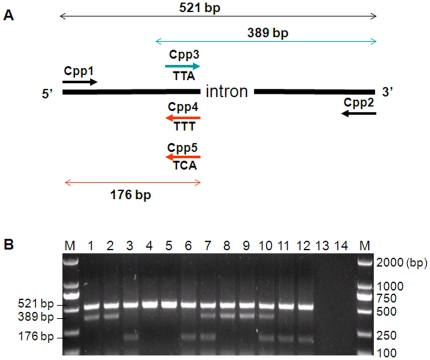
Allele-Specific PCR (AS-PCR) for kdr genotyping.
A: Schematic representation of the primer location and predicted size of PCR products. Cpp1–Cpp5 indicate PCR primers in which sequences are reported in Table 5. Primer pair Cpp2 and Cpp3 amplifies a 389 bp fragment for the wildtype susceptible allele (for codon TTA). Primer pair Cpp1/Cpp4 yields a 176 bp fragment for resistant L1014F allele (codon TTT). Similarly, primer pair Cpp1/Cpp5 leads to amplification of a 176 bp fragment diagnostic to the L1014S resistant allele (for codon TCA). B: An example of AS-PCR gel. Two PCR reactions were run in parallel for each specimen (lanes 1 and 2 for specimen 1; lanes 3 and 4 for specimen 2…). Samples in lanes 1, 3, 5, 7, 9 and 11 were amplified with the primers Cpp1, Cpp2, Cpp3 and Cpp4 to detect wildtype L1014 (TTA) and resistant L1014F (TTT) alleles, whereas samples in lanes 2, 4, 6, 8, 10 and 12 were amplified with primers Cpp1, Cpp2, Cpp3 and Cpp5 to detect wildtype L1014 (TTA) and resistant L1014S (TCA) alleles. Lanes 13 and 14 were negative control. Genotype results: specimen 1: TTA/TTA; specimen 2: TTT/TTT; specimen 3: TCA/TCA; specimen 4: TTA/TTT; specimen 5: TTA/TCA; and specimen 6: TTT/TCA.